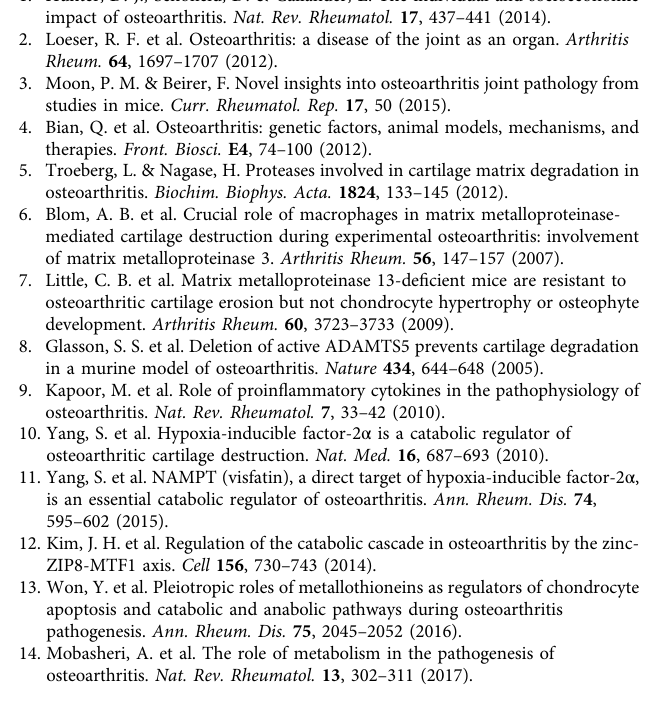
Table 2. qRT-PCR was performed using an iCycler thermal cycler (Bio-Rad) and SYBR premixExTaq reagents (TaKaRa Bio). For each target gene, transcript levels were normalized to that of glyceraldehyde-3-phosphate dehydrogenase (GAPDH) and expressed as fold-change relative to the indicated control. Western blotting . Total cell lysates were prepared in lysis buffer (150mM NaCl, 1% NP-40, 50mM Tris, 0.2% sodium dodecyl sulfate [SDS], and 5mM NaF) and used to detect ERR γ . Secreted proteins (MMP3 and MMP13) were detected after trichloroacetic acid (TCA) precipitation of proteins from 900 μ l of serum-free conditioned medium. All lysis buffers contained a cocktail of protease inhibitors and phosphatase inhibitors (Roche). The following antibodies were used for Western blotting: rabbit polyclonal anti-ERR γ (sc-66883) from Santa Cruz, and mouse monoclonal anti-MMP3 (clone EP1186Y) and anti-MMP13 (clone EP1263Y) from